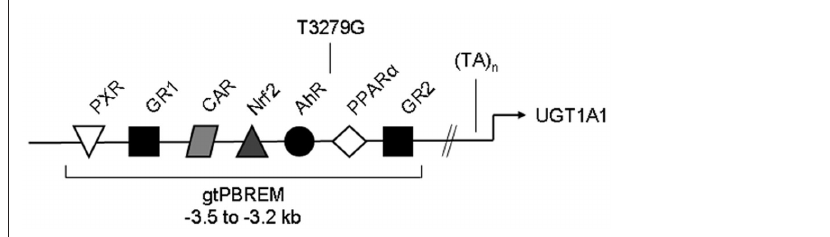
Figure 1 | Schematic illustration of allelic variants and the position of response elements binding ligand-activated transcription factors in the enhancer/promoter region of human ugT1A1. Positions are taken from Sugatani et al. (2005), and Bock and Köhle (2010). For discussion see